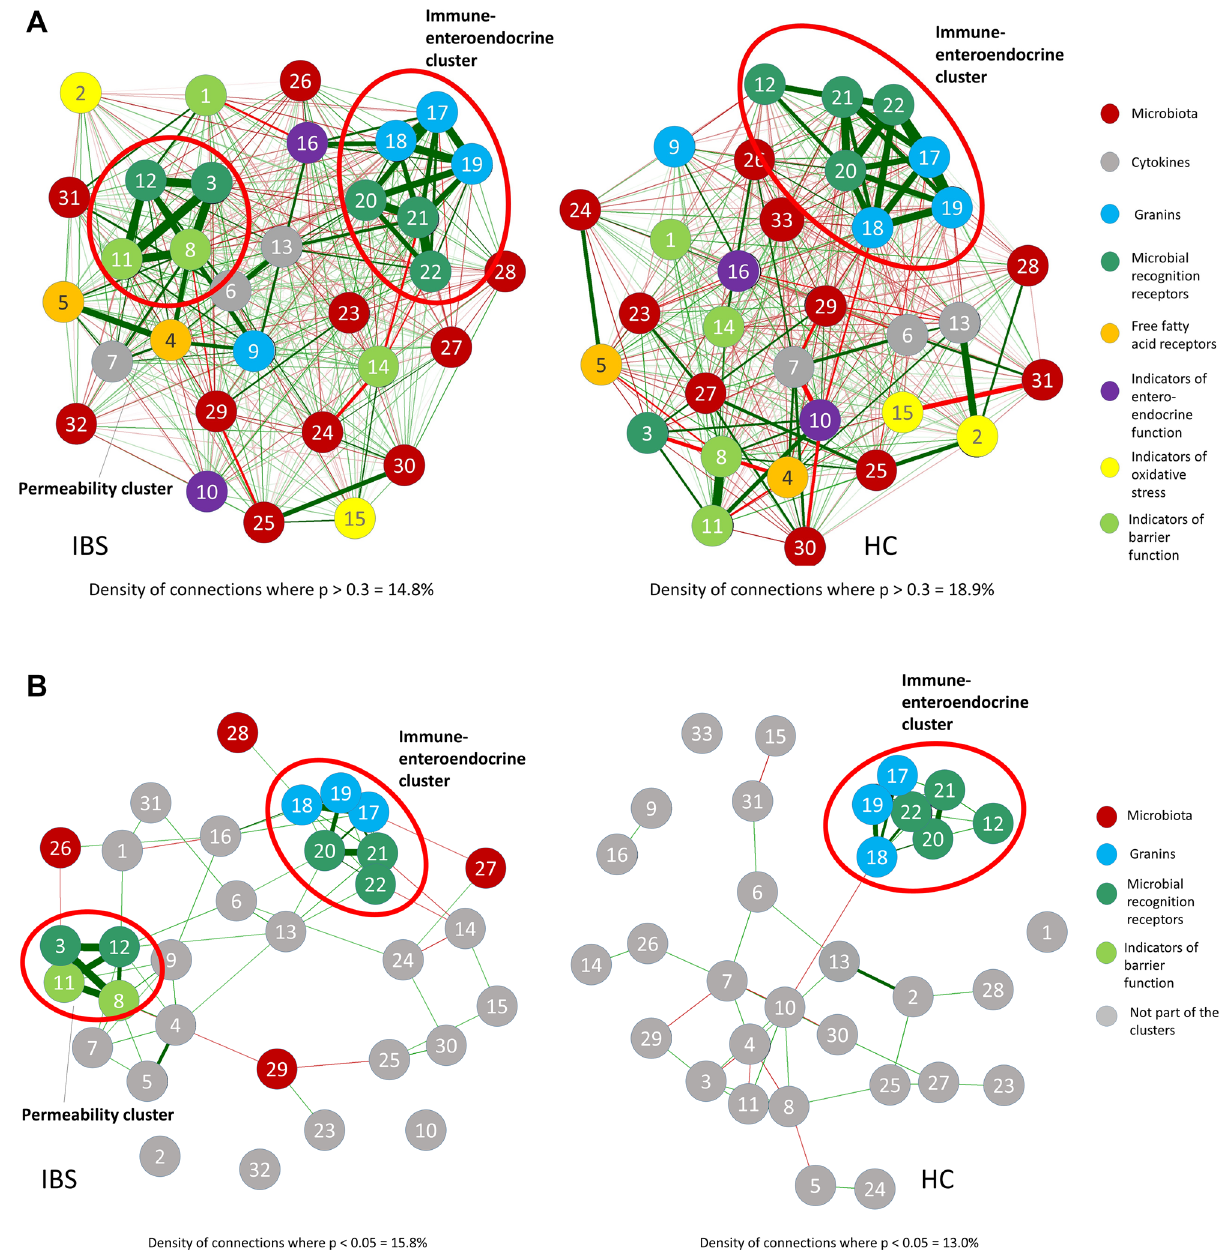
Figure 4. Integrative analysis on phylum level. ( A ) Overview, all correlations are plotted in relative correlation strength (disregarding statistical significance) to understand the relationships between the variables present in the given cohorts. Clusters of high intercorrelation are marked with a red circle. ( B ) Significance test: Only statistically significant correlations are plotted to estimate the generalizability of the patterns. Highlighted in color are the intercorrelation clusters. Clusters of high intercorrelation are marked with a red circle. Green edges show positive correlation, red edges negative correlation. Closer proximity of nodes and thicker edges show higher relative correlation strength. 1 = CLD1; 2 = DOUX2; 3 = PAR2; 4 = FFAR2; 5 = FFAR3; 6 = IL10; 7 = IL8; 8 = OCLN; 9 = SCG2; 10 = SLC6A4; 11 = TJP1; 12 = TLR4; 13 = TNFα; 14 = MUC; 15 = NOX1; 16 = TPH1; 17 = CHGA; 18 = CHGB; 19 = SCG3; 20 = TLR2; 21 = TLR6; 22 = TLR9; 23 = unclassified bacteria; 24 = Actinobacteria; 25 = Bacteroidetes; 26 = Chlamydiae; 27 = Firmicutes; 28 = Fusobacteria; 29 = Lentisphaerae; 30 = Proteobacteria; 31 = Tenericutes; 32 = Verrucomicrobia; 33 =